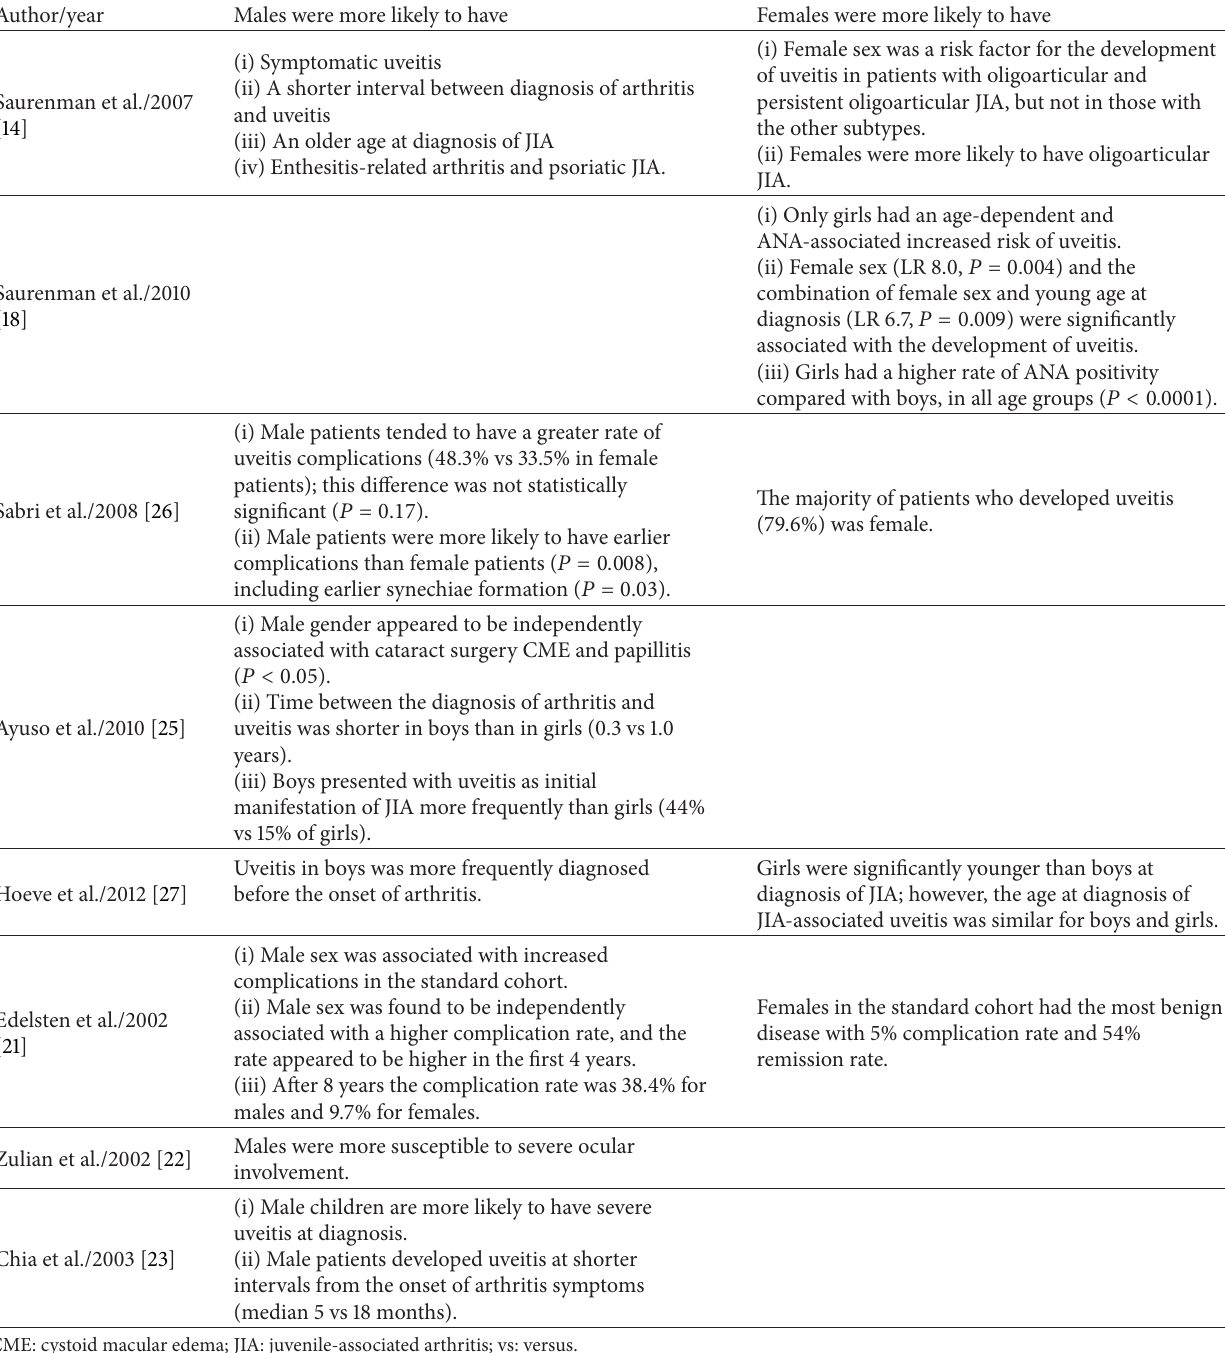
Table 3: Summary of gender specific findings in patients with JIA-associated uveitis in some of the recent published